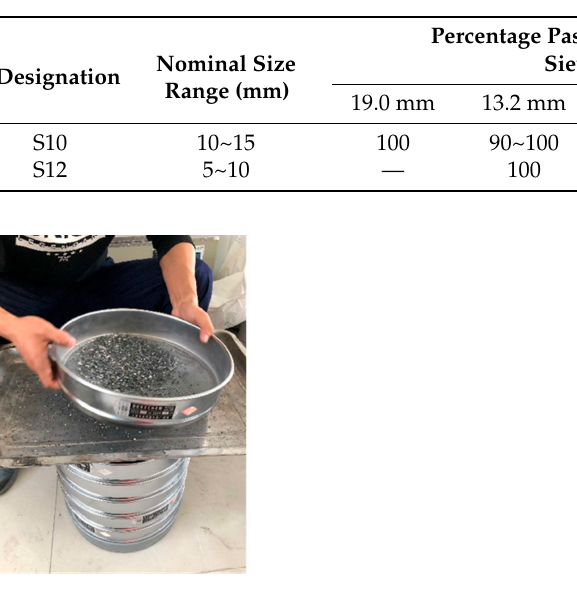
Table 1. Specifications of coarse aggregate.